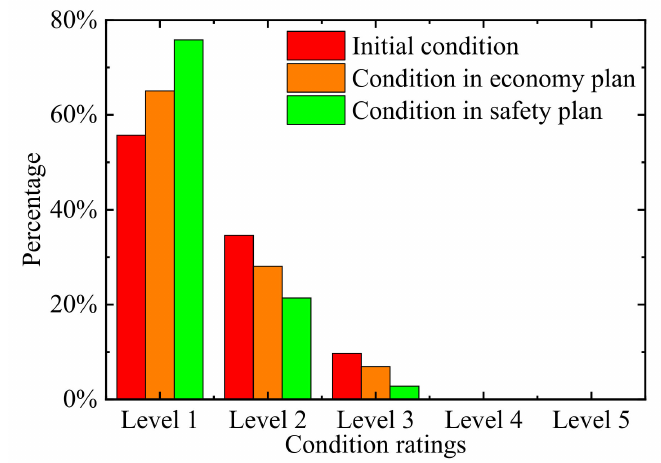
Figure 11. Comparison of the optimal maintenance